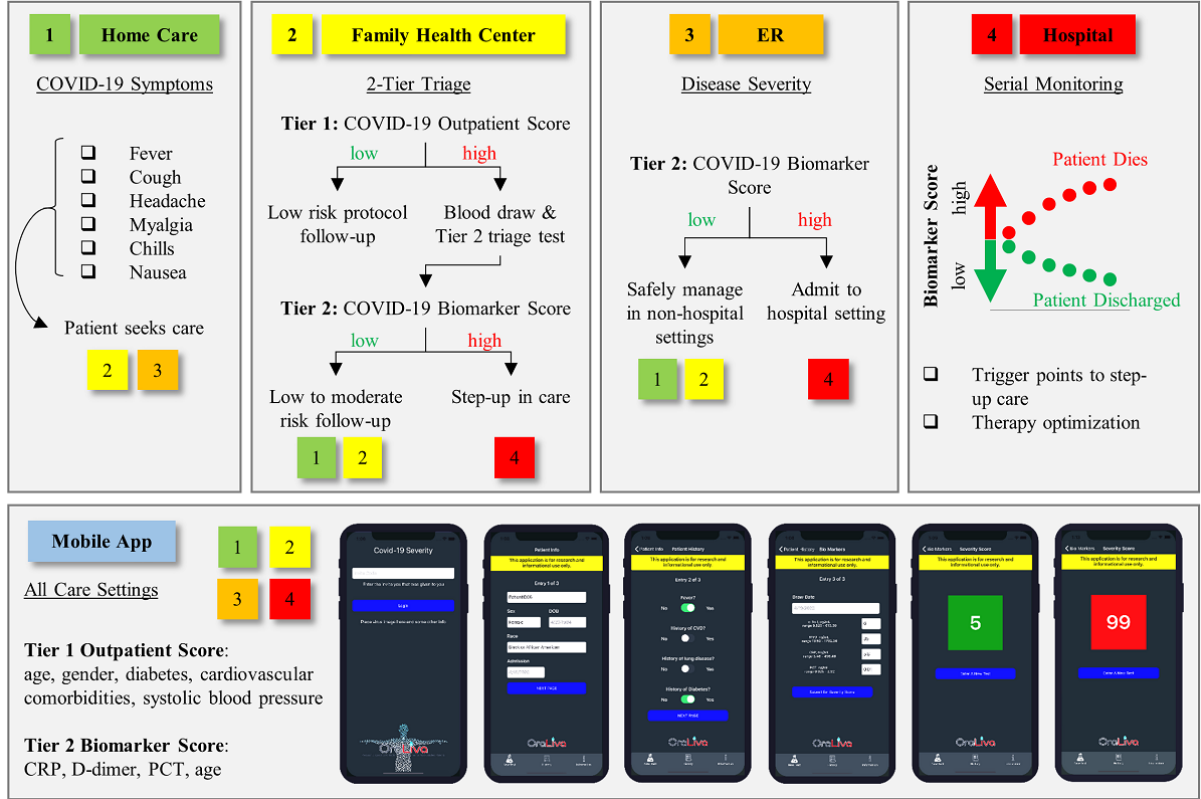
Figure 1. Clinical decision support system and mobile app for managing COVID-19 care. COVID-19: coronavirus disease; CRP: C-reactive protein; PCT: